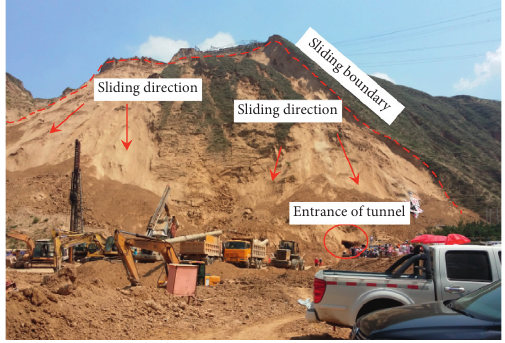
Figure 7: Front slope